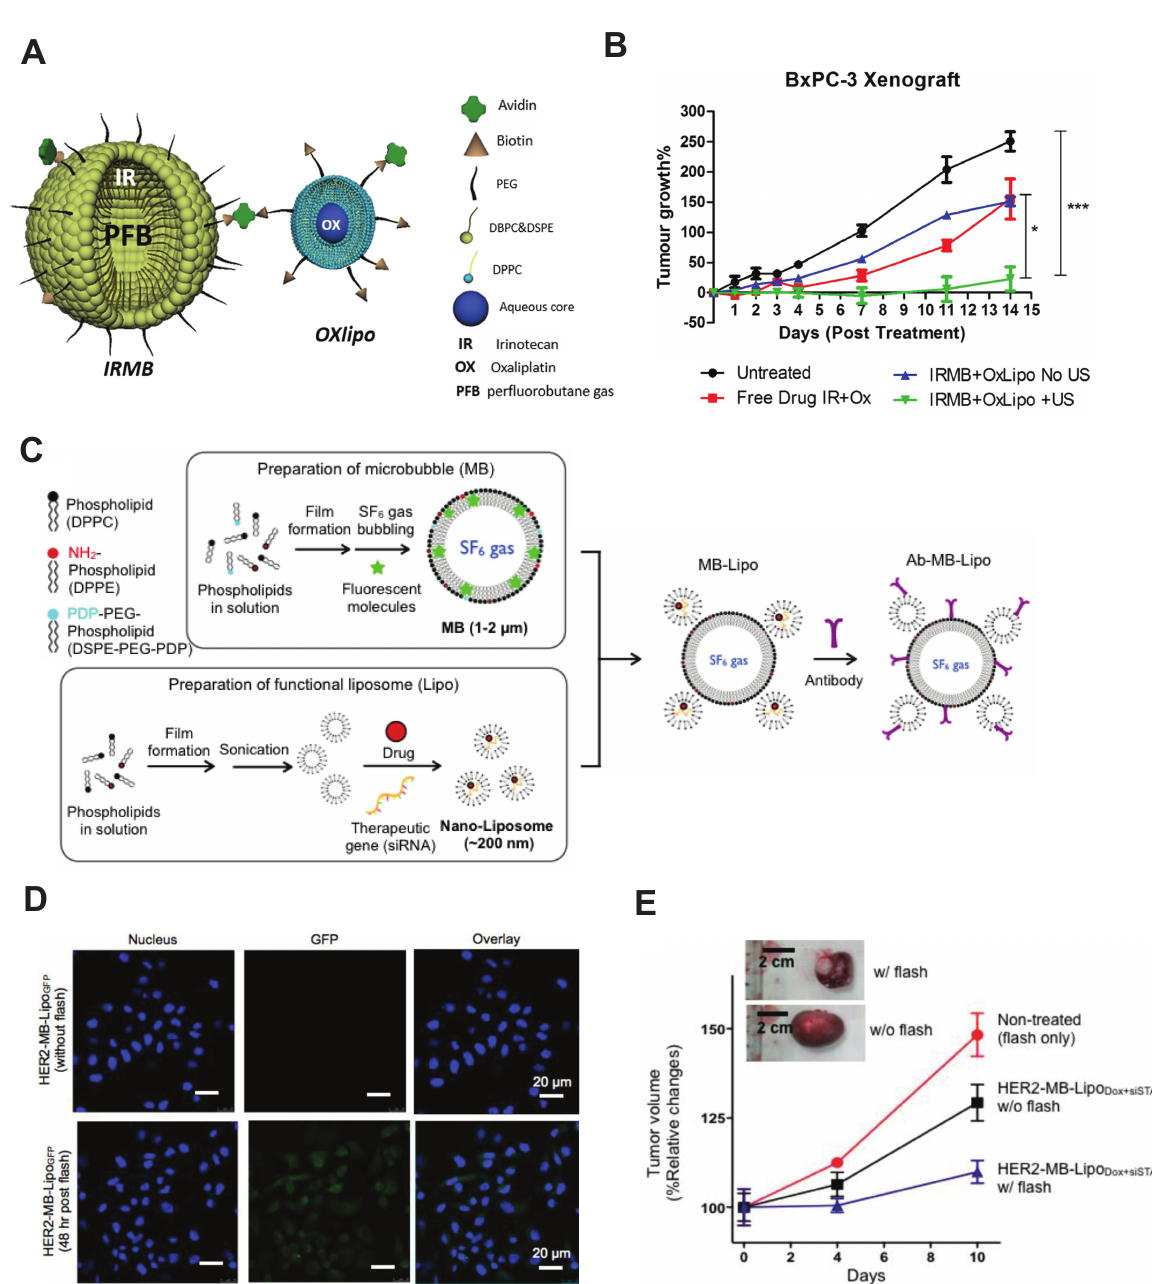
Figure 3. Microbubble–liposome complexes expand the types of cargo that can be delivered by ultrasound-induced microbubble cavitation, leading to improved therapeutic efficacy. ( A ) Microbub- bles loaded with hydrophobic chemotherapeutic Irinotecan and liposomes loaded with hydrophilic chemotherapeutic Oxaliplatin were linked together by biotin–avidin bridging for a multi-drug cancer therapy approach. ( B ) Implementation of this system (IRMB + OxLipo + US, green) in vivo resulted in significantly lower tumor growth than delivery without ultrasound (blue), * p < 0.05, *** p < 0.0001. ( A , B ) reprinted from [154], copyright 2020, with permission from Elsevier. ( C ). Both DOX and thera- peutic siRNA were loaded into liposomes, which were covalently conjugated to microbubbles and labeled with antibodies for multidrug active targeting. ( D ) Ultrasound-stimulated delivery (flash) of this complex promoted cell uptake and gene transfection (bottom row). ( E ) This therapeutic microcarrier complex design inhibited tumor growth when stimulated with ultrasound (flash) in vivo (shown in blue). ( C – E ) reprinted from [155], copyright 2014, Ivyspring International